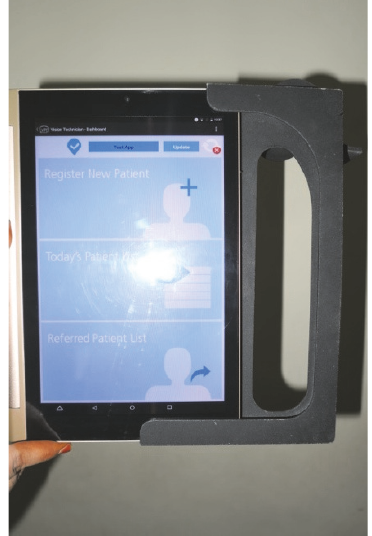
Figure 11: Insertion of tablet into eyeSmart Cyclops.